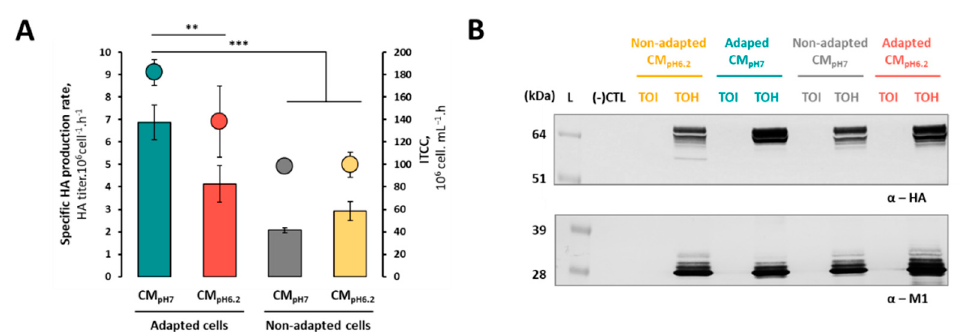
Figure 2. Impact of pH shift on HA production. ( A ) Bars represent specific HA productivity (HA titer.10 6 cell − 1 .h − 1 ) and dots represent total number of cells during production phase (integral of total cell concentration, ITCC, 10 6 cell.mL − 1 .h) of adapted and non-adapted cells in neutral pH culture medium (CM pH7 ) or in standard pH 6.2 (CM pH6.2 ); ( B ) identification of HA and M1 proteins by Western blot; samples were collected at the time-of-infection (TOI) and time-of-harvest (TOH) for adapted and non-adapted cells in neutral pH culture medium (CM pH7 ) or in standard pH 6.2 (CM pH6.2 ). Samples loaded are clarified supernatants, non-diluted; same volume was loaded in the gel for all samples. Relative band intensities for TOH samples (overproduction with non-adapted cells in CM pH6.2 ) are 1.5:0.8:1.6 (for HA) and 1.1:0.8:1.5 (for M1) for adapted cells-CM pH7 : non-adapted cells-CM pH7 : adapted cells-CM pH6.2 , respectively. Uncropped membranes can be observed in Supplementary Figure S2. For Figure ( A ): data are relative to three biological replicates (n = 3); di ff erences were tested with one-way ANOVA using Dunnett’s multiple comparisons test (** = adjusted p -value < 0.005 and *** = adjusted p-value < 0.001 were considered statistically significant). For Figure ( B ): (-) CTL denotes negative control (supernatant of non-infected cells) and L denotes pre-stained protein standard SeeBlue ® Plus2.